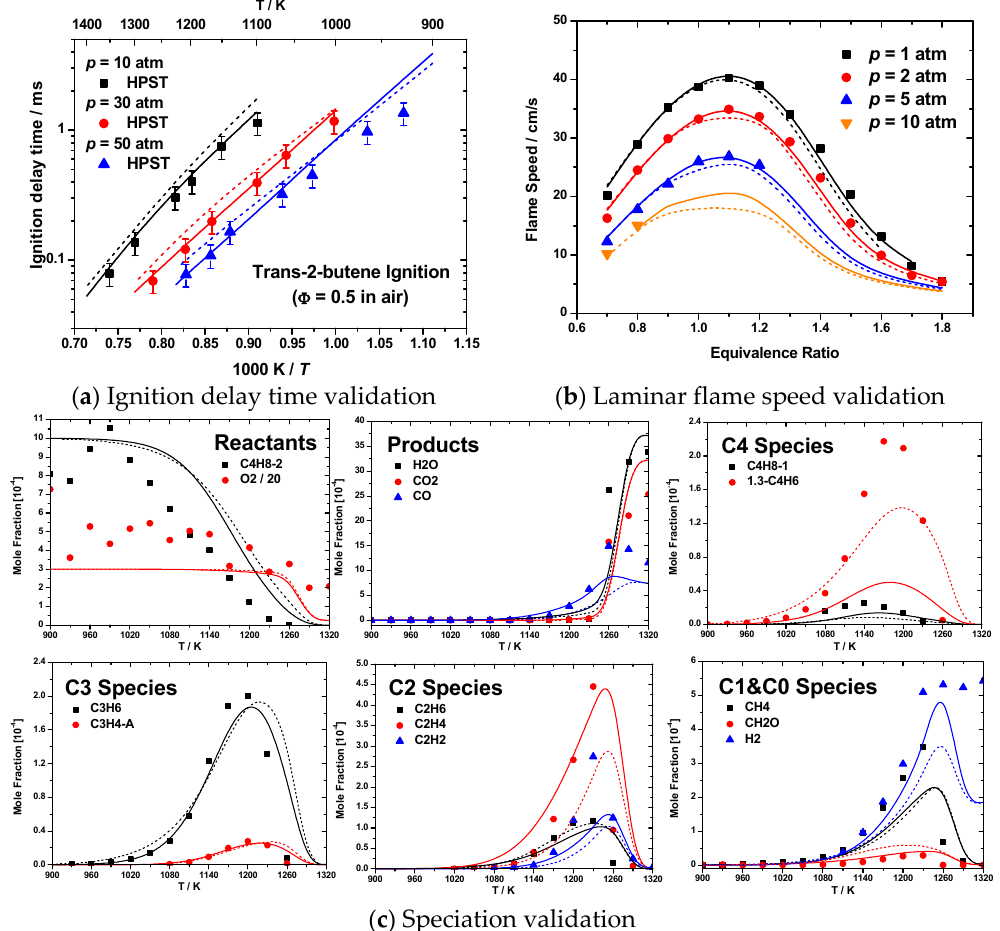
Figure 6. Ignition delay time, laminar flame speed, and speciation validation results for 2-butene.